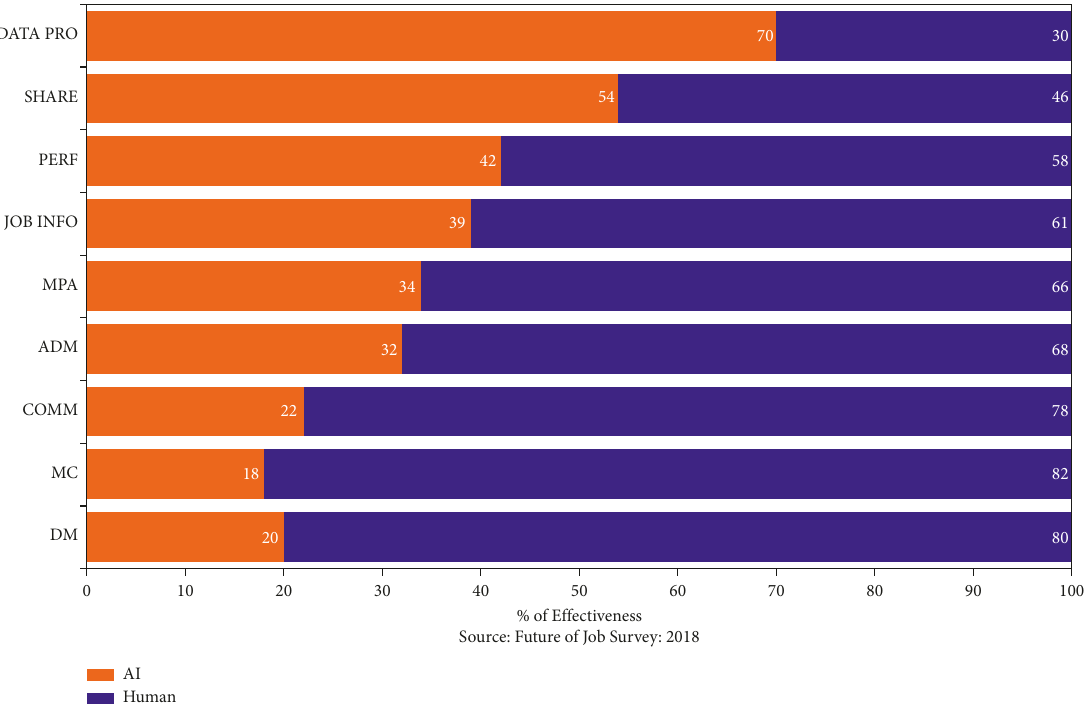
Figure 10: Effectiveness of AI tools in firm decision-making process (2018).